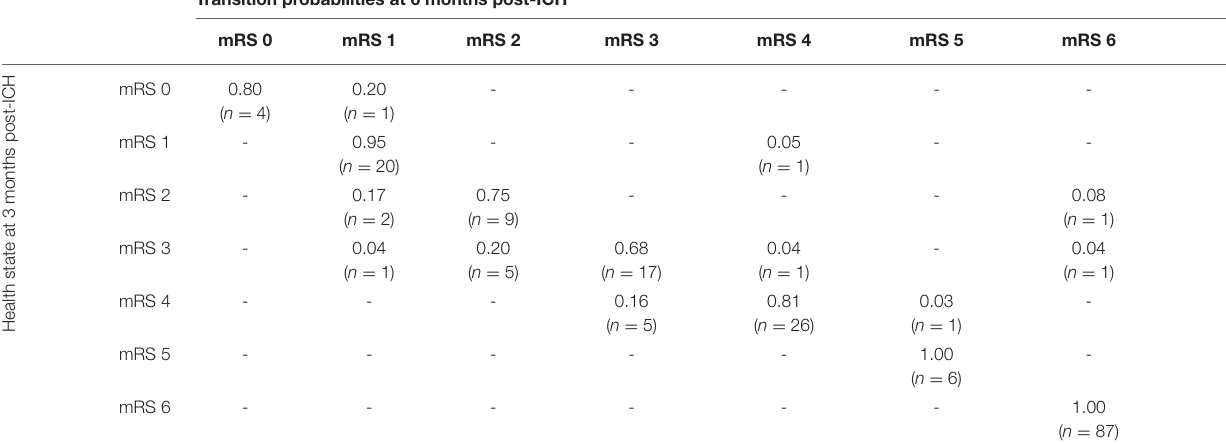
TABLE 2 | Transition probabilities. Transition probabilities at 6 months